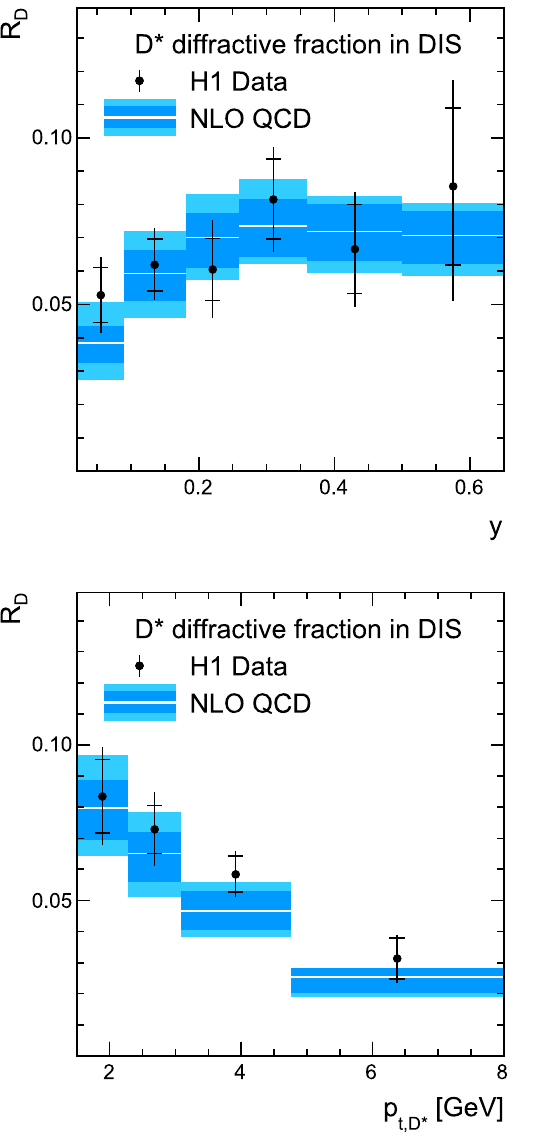
NLOQCDpredictionof R D byHVQDIS isshown asa whitelineinside the coloured bands . The inner band represents DPDF uncertainty. The outer band represents effect of the DPDF uncertainty and simultane- ous variations of scales, charm mass and fragmentation settings in